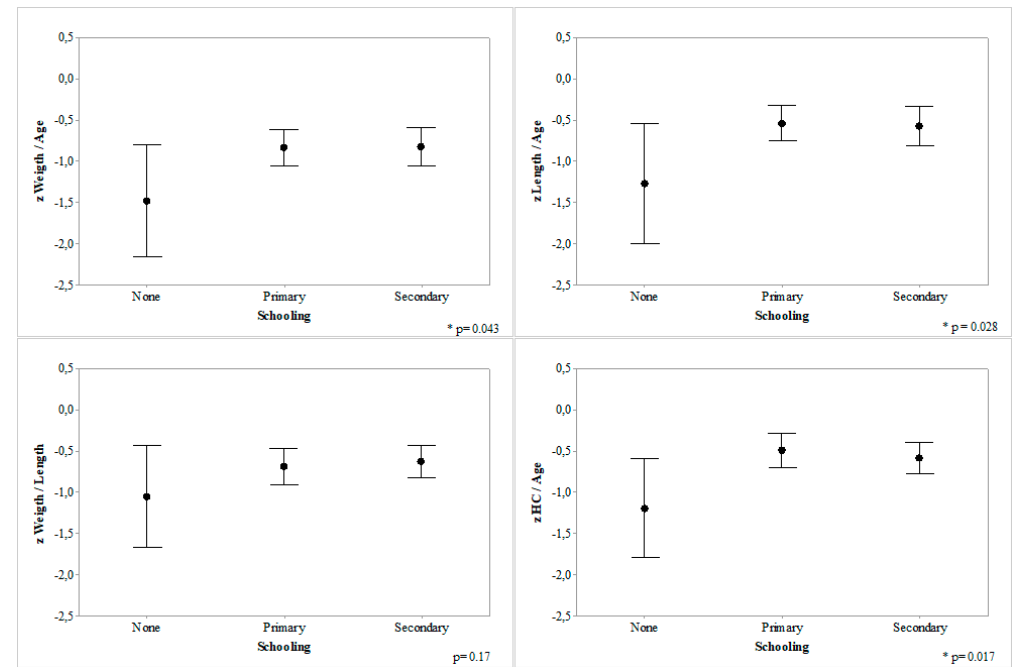
Figure 3. z -score of anthropometric indices according to maternal education, in 278 infants seen at the Klinik Saint Espri Health Center, Port au Prince, Haiti (August 2014). Footnote: 95% Confidence Interval, medians represented by black circles. * p < 0.05, ANOVA. Comparing children from mothers lacking formal education with those with mothers having primary or secondary education.